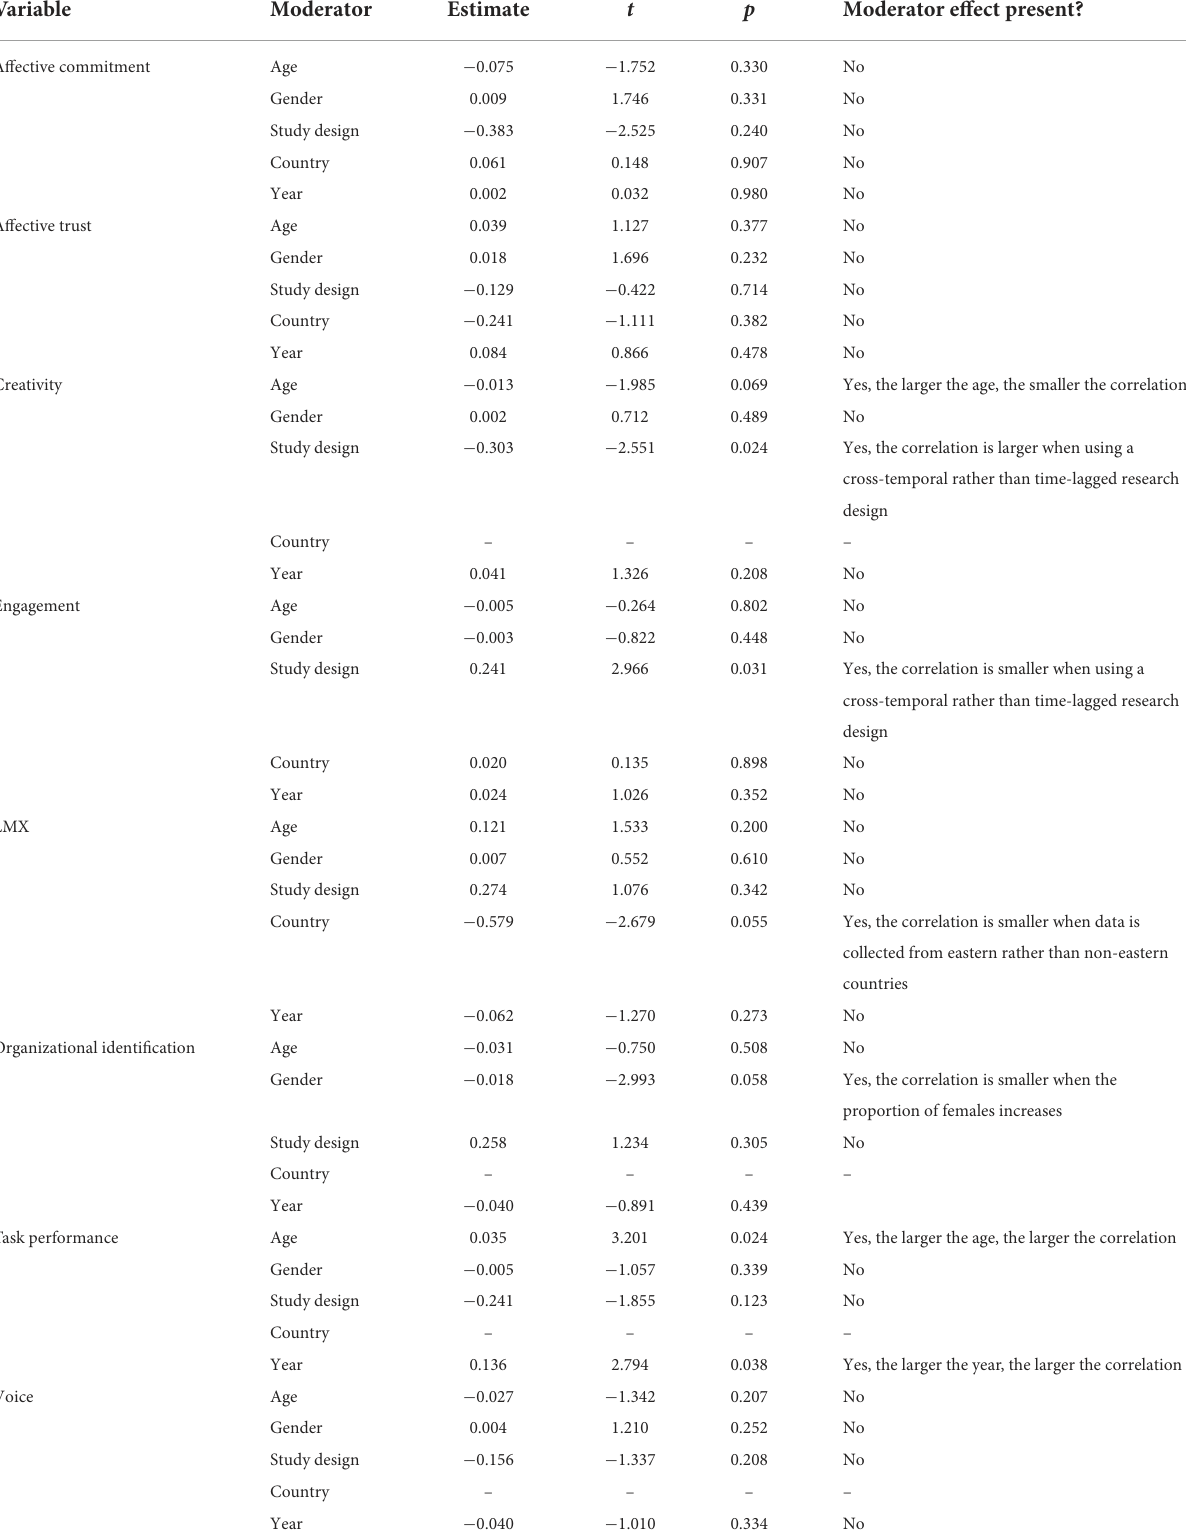
TABLE 7 Moderation